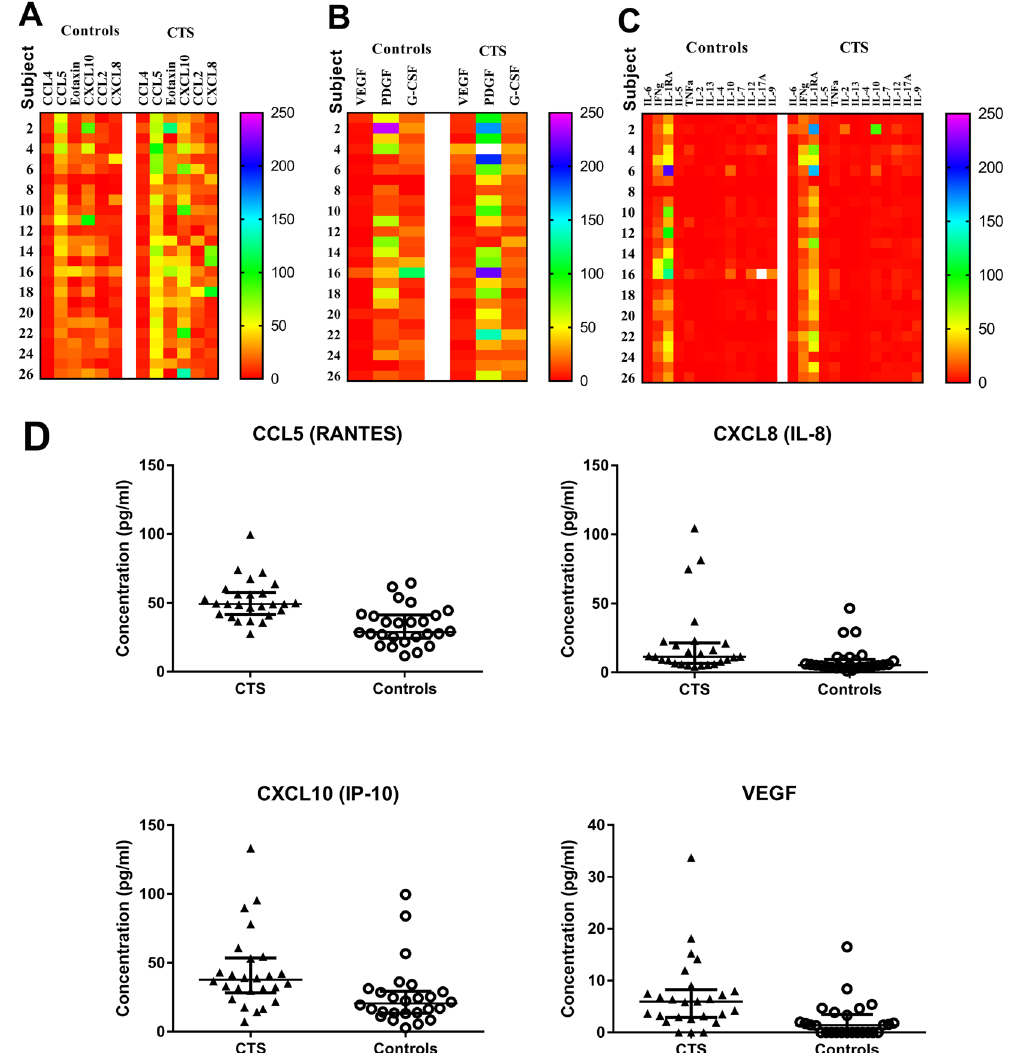
Figure 1. Serum cytokine/chemokine levels in CTS patients. Heat maps comparing the expression profile of control and CTS serum cytokines, which are grouped as ( A ) Chemokines; ( B ) Growth factors; and ( C ). Cytokines. Values are median cytokine concentration (pg/ml), with red indicating lowest levels, blue-purple indicating highest levels, and yellow-green indicating median levels. ( D ) Serum CCL5, CXCL8, CXCL10 and VEGF levels are significantly increased in CTS patients (n = 26) relative to healthy controls (n = 26). Lines represent the median and interquartile